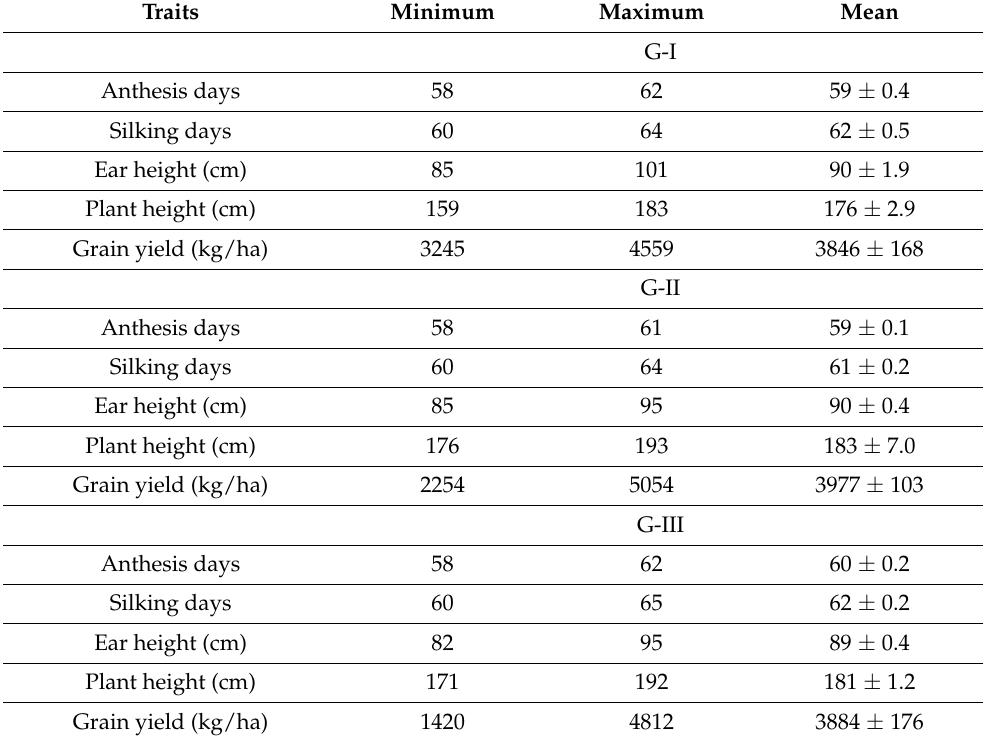
Table 5. Minimum, maximum, and mean agronomic traits for the four groups of hybrids (G-I, G-II, and G-III) defined based on canonical discriminant analyses of carotenoids. Traits Minimum Maximum Mean G-I Anthesis days 58 59 ± 0.4 Silking